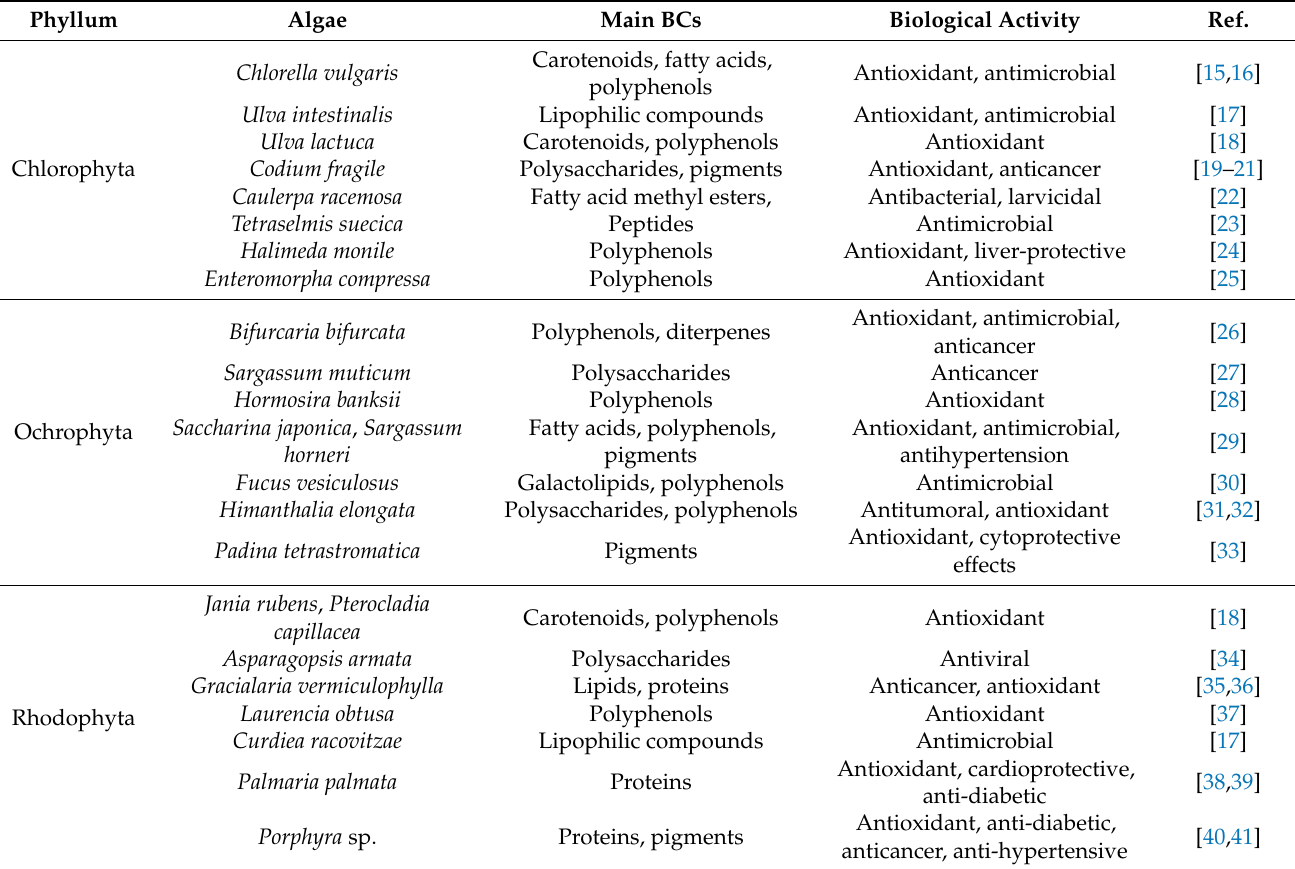
Table 1. Different BCs related to the biological properties of marine algae